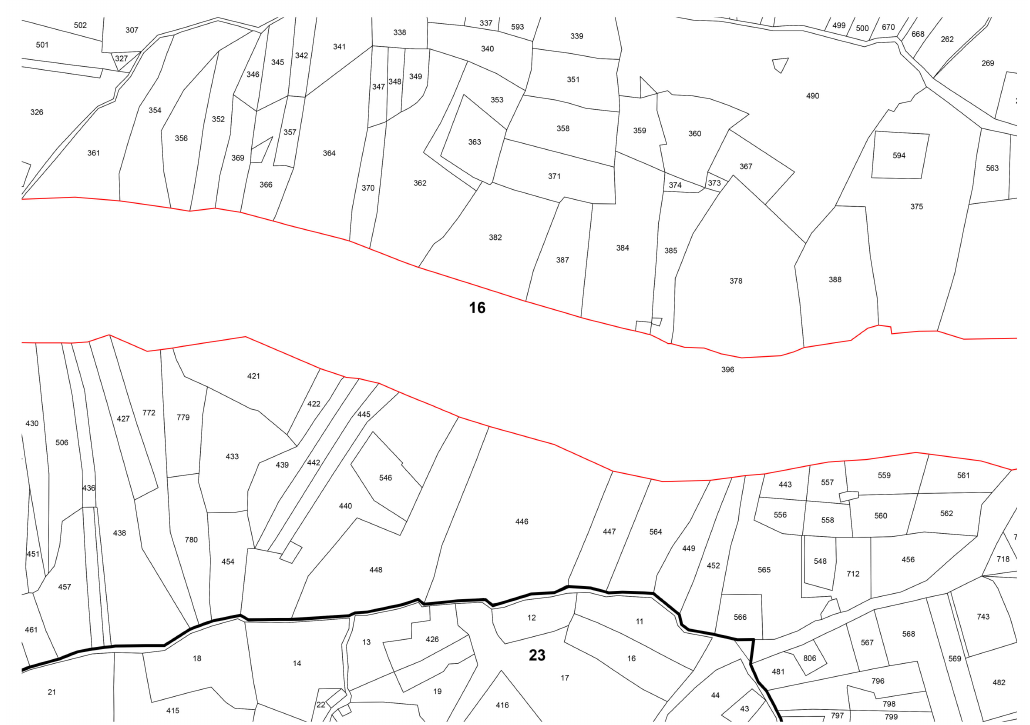
Figure A5. Details of land registry maps. The tratturo is represented with a red line and usually it is identified as a unique linear parcel with variable size; in the figure the tratturo is the parcel number 396 in sheet number